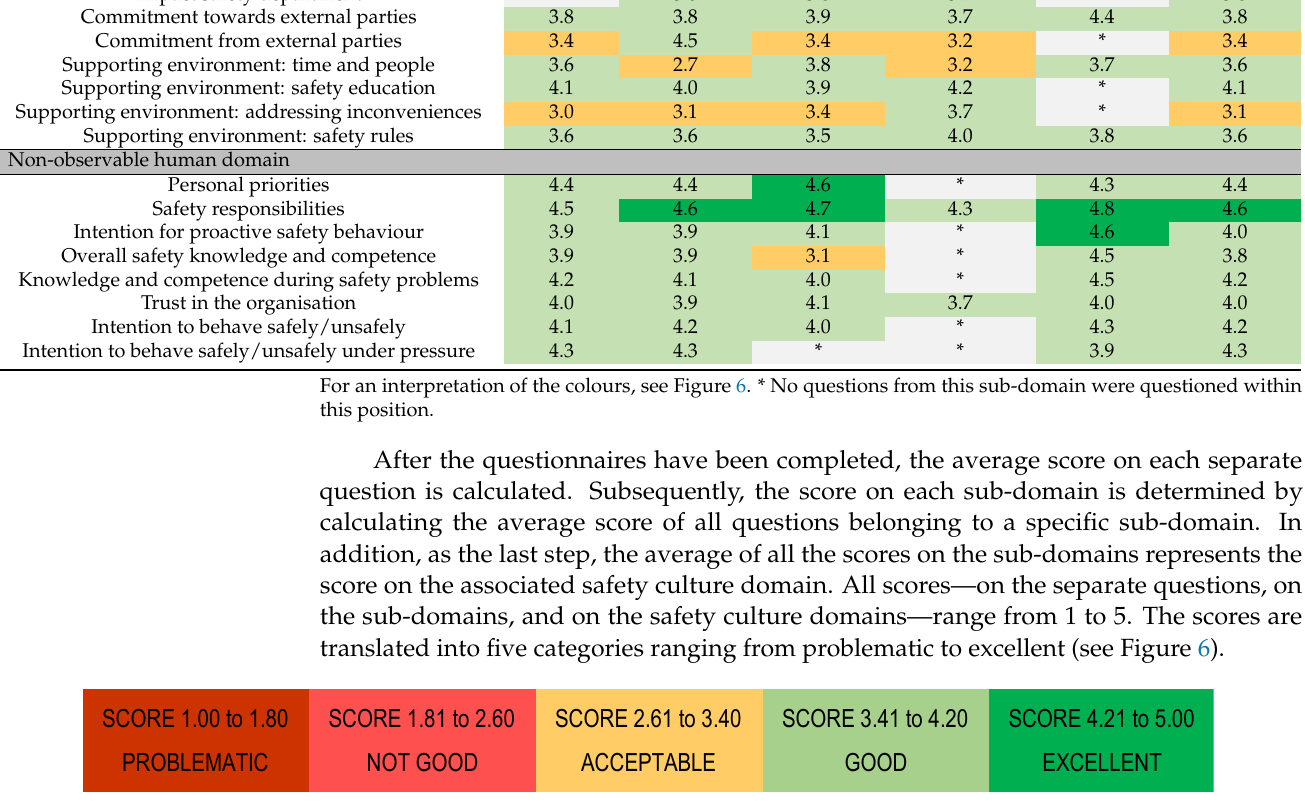
Figure 6. Interpretation of the questionnaire results.